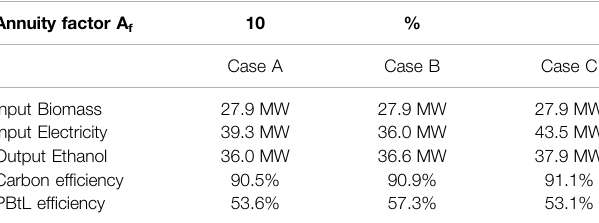
TABLE 3 | Key performance indicators of the process in cases A –